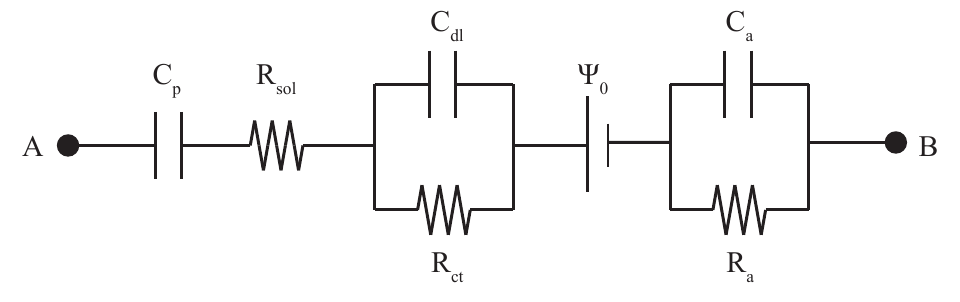
Figure 2. Electrical model of the TiO 2 sample tested in an aqueous